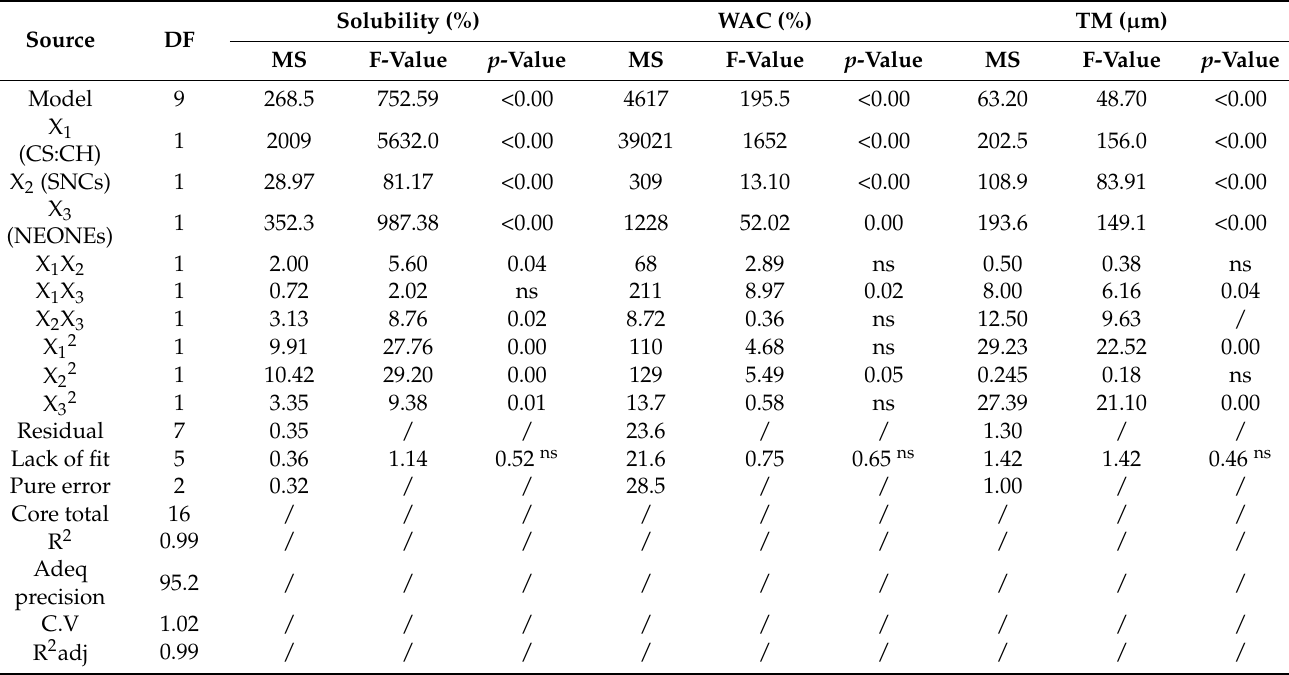
Table 3. Analysis of variance (ANOVA) table for the second-order polynomial models constructed for each of the studied response